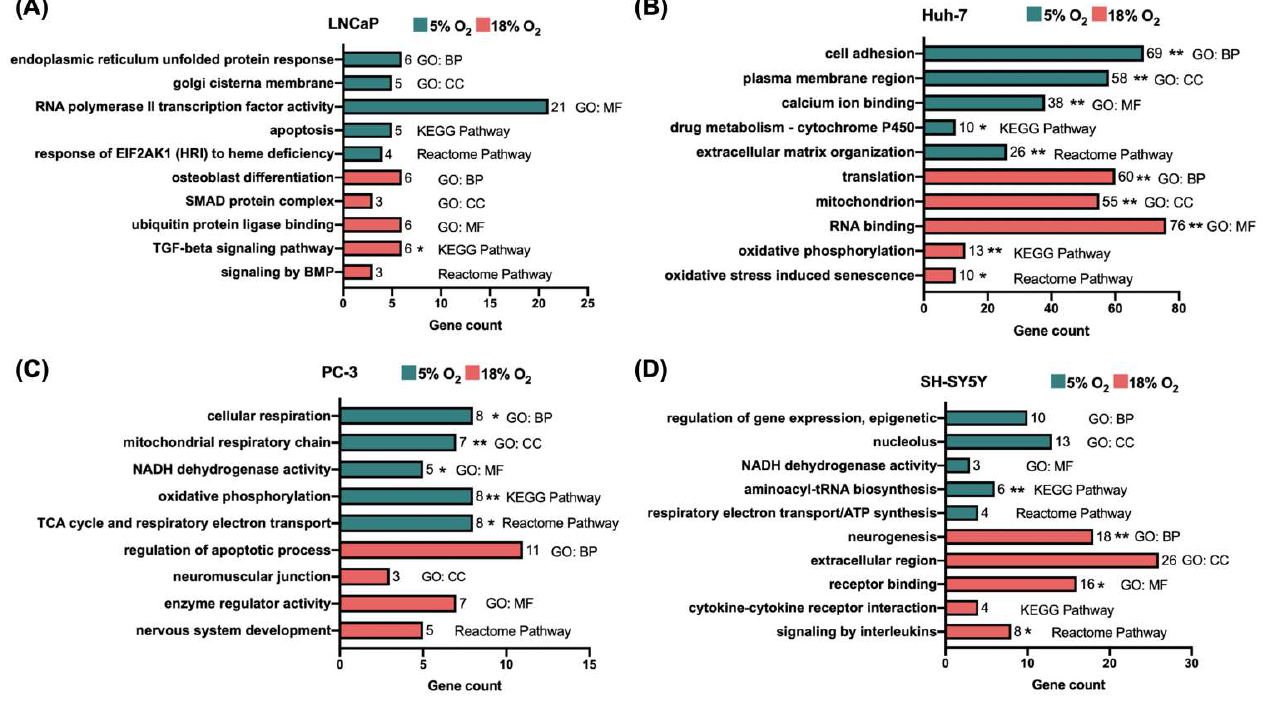
Table 1. Selected DEGs at 18% O 2 vs 5% O 2 with important roles in cancer